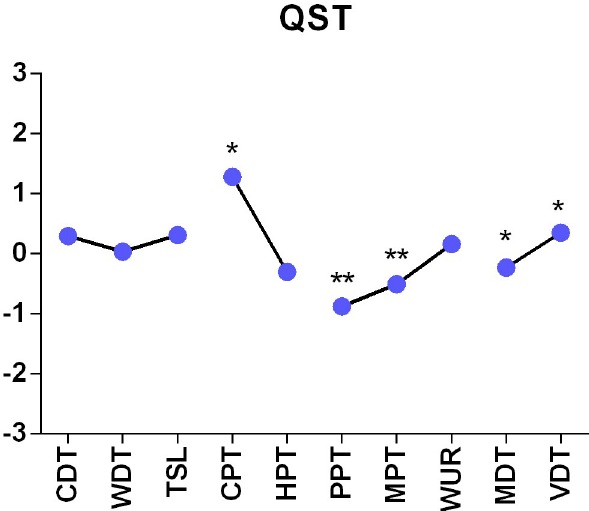
Fig 5. Z-adjusted values of the variables measured in quantitative sensory testing in FMS patients relative to healthy controls. � p < 0.05, �� p < 0.001; we used ANOVA for statistical testing. CDT = cold detection threshold, WDT = warm detection threshold, CPT = cold pain threshold, HPT = heat pain threshold, TSL = temperature sensory limen, MDT = mechanical detection threshold, MPT = mechanical pain threshold, WUR = wind up ratio, PPT = pressure pain threshold, VDT = vibration detection